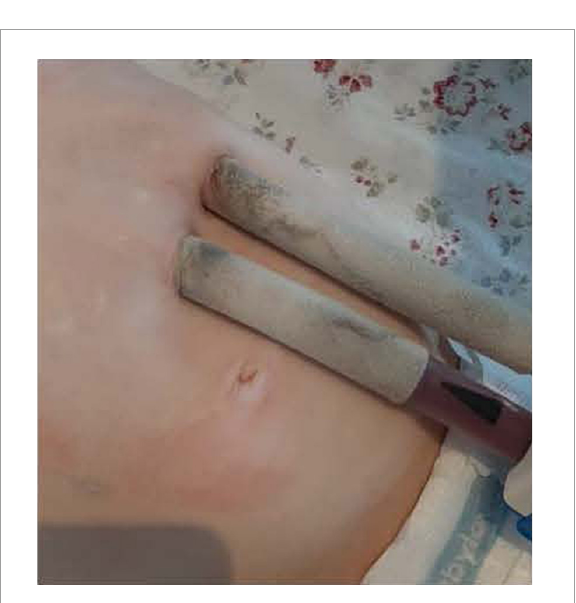
FIGURE2 No detectable wound healing disorders after 5 months out of